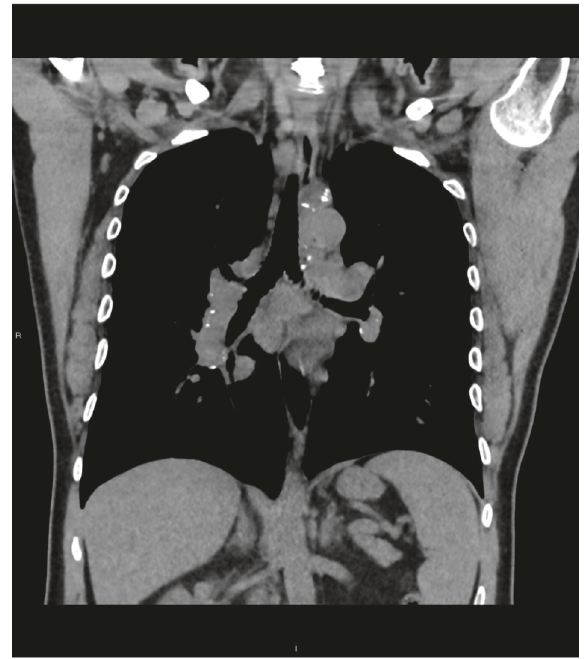
Figure 3: Chest CT: mediastinal and hilar adenopathy with coarse eggshell